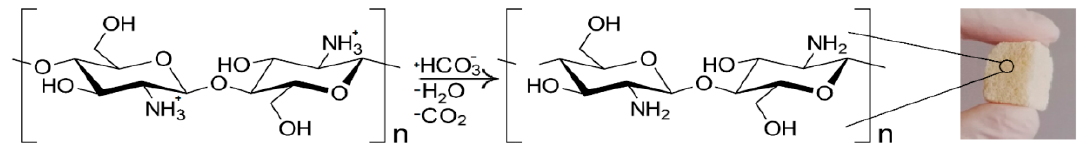
Figure 7. Scheme of the reaction of the interaction of chitosan with ammonium bicarbonate.